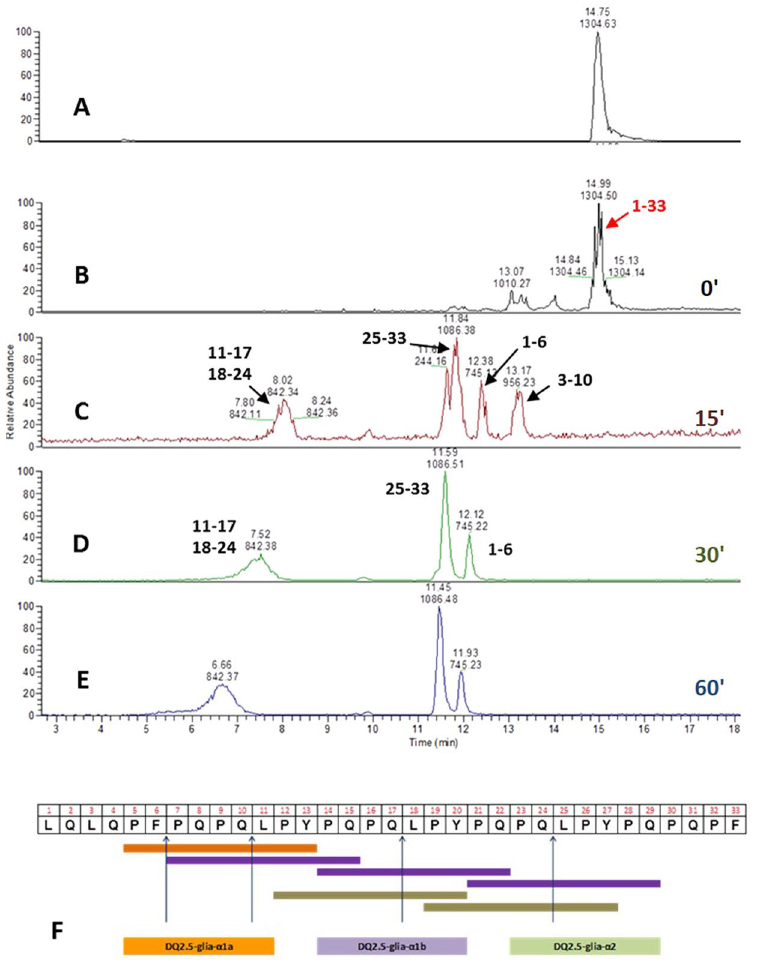
Figure 5. E40 completely removes the immunogenicity of the 33-mer peptide. LC/MS profile of 33-mer digestion by E40 at pH 5 and 37 °C, with E40 in a molar ratio 1:48 versus peptide. Panel (A): Trace of full length peptide alone (triply charged ion [(M + 3 H + ) 3 + = 1304.68]). Panels (B–E): Time-course of 33-mer cleavage by E40 activity (from to top-bottom 0, 15, 30, 60 minutes digestion, respectively). Peptide fragments formed during digestion are indicated by arrows. Rapid action of E40 onto the substrate can be visible at time 0 ′ , complete disappearance of 33-mer is obtained already after 15 ′ of digestion. Panel (F): Schematic visualization of E40 cleavage sites deduced from the final residual peptides which demonstrates the complete epitopes destruction since 30 ′